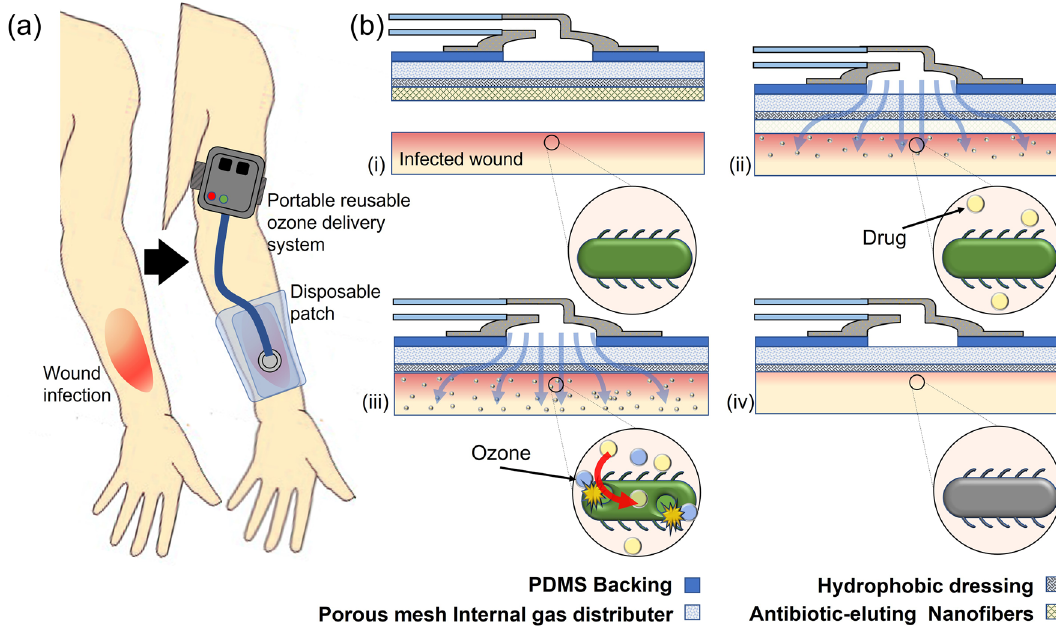
Figure 1. Wearable adjunct ozone and topical antibiotic therapy system. ( a ) Ozone and antibiotic adjunct therapy can be used as an alternative treatment for skin and soft tissue infections that do not respond to traditional therapies. Ozone provides antimicrobial properties and enables antibiotic to enter cell and disrupt cell functions, such as protein production. ( b )The system utilizes gaseous ozone and gas permeable and drug- eluting nanofiber mat for treating developing wounds in the following process: (i) All-in-one wound patch with drug-eluting nanofiber mesh and gas permeable membrane is applied to skin wound. (ii) NFs begin to dissolve and release the topical antibiotics. (iii) Ozone is applied to the system for full treatment duration as topical antibiotics are completely released from NFs. Ozone and antibiotics work together to eliminate infection. (iv) Once the wound has healed, the wound patch is removed from the area. Combination of ozone and antibiotic treatment can treat antibiotic resistance infections and prevent development of new infections, leading to faster healing